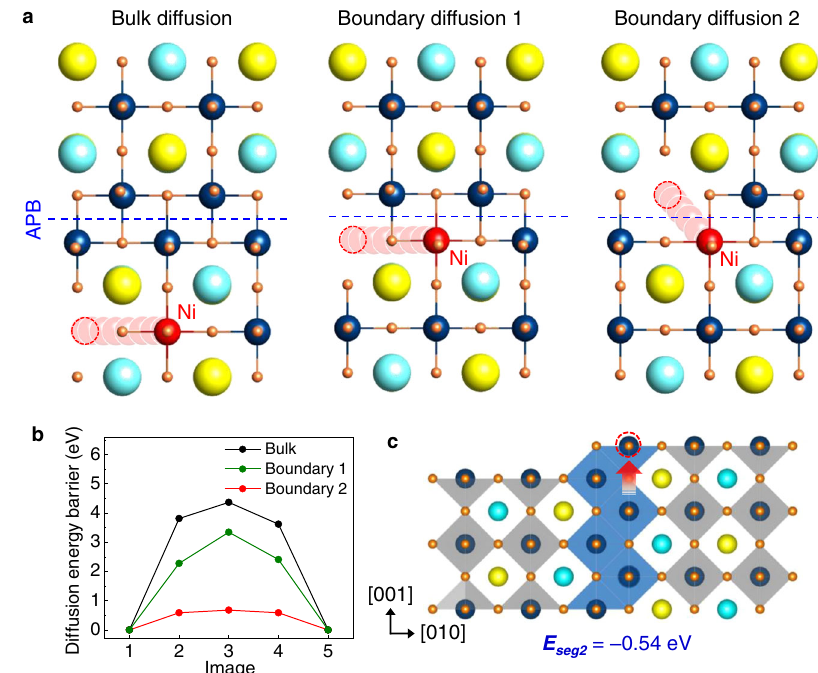
Fig. 4 | DFT calculation for the migration barriers of Ni in the vicinity of APB. a Threemigrationpathways;bulkdiffusion,diffusionparalleltotheAPB(Boundary diffusion 1),and diffusion across the APB (Boundarydiffusion 2). b Energy barriers calculatedforthethreemigrationpathways.ThemigrationofNitowardthenearest neighboring B-site far from an APB yields 4.37eV. The energy barrier for a similar